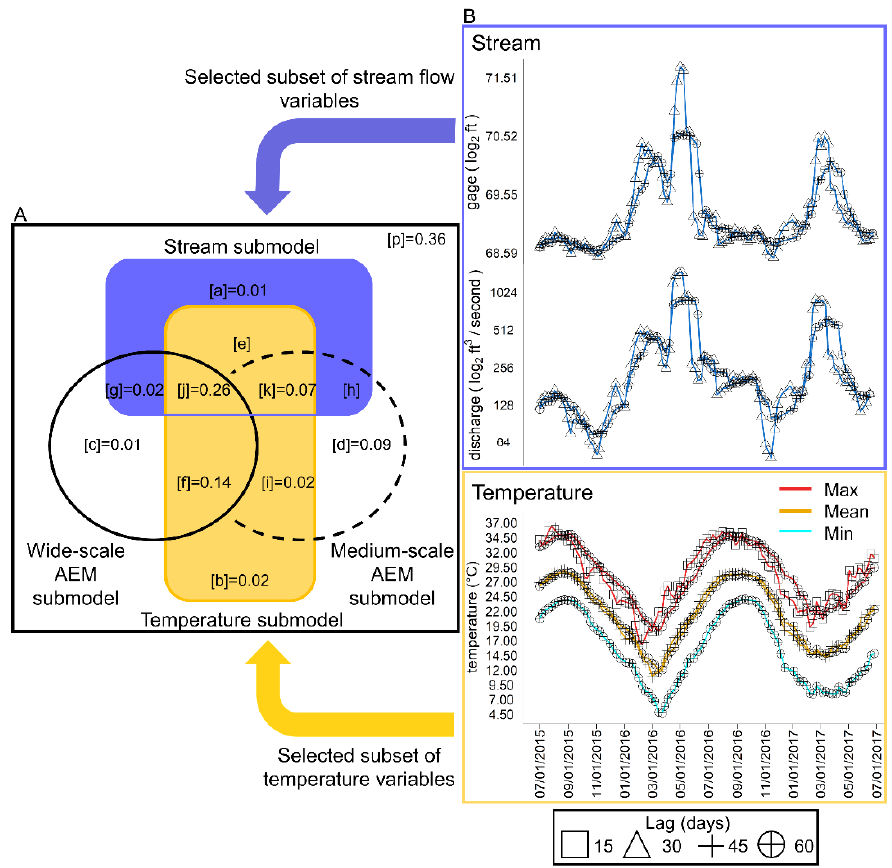
Figure 3. Culicoides dynamics are shaped by environmental and time-related constraints. ( A ) describes the proportion of weekly Culicoides composition variation concurrently explained by environmental (stream submodel and temperature submodel) and temporal (wide- and medium-scale submodels) determinants. The continuous line represents the wide-scale temporal submodel, and the discontinuous line is the medium-scale temporal submodel. The yellow color diagram represents the temperature submodel, and the stream derived submodel is light blue. Each fraction shows the corresponding R 2 adj and [e] and [h] R 2 adj ≈ 0 . Unique and additive fractions were significant after permutations analysis ( n = 1000, p < 0.01). ( B ) Observed fluctuations in stream (upper blue panel) and temperature (yellow bottom panel) selected variables (metrics and days-lag) are plotted against sampling weeks. Then, the stream submodel was comprised of the mean gauge height (ft; upper side of stream metrics panel) and discharge flow (ft 3 / second; bottom side of stream metrics panel) at 30 and 60 days lag by the forward selection scheme proposed. Both are showed in log 2 scale for improving visualization. The temperature submodel comprises minimum (cyan line; 60 days lag), maximum (golden line, 15 and 30 days lag) and mean (red line, 45 and 60 days lag) metrics after forward selection.